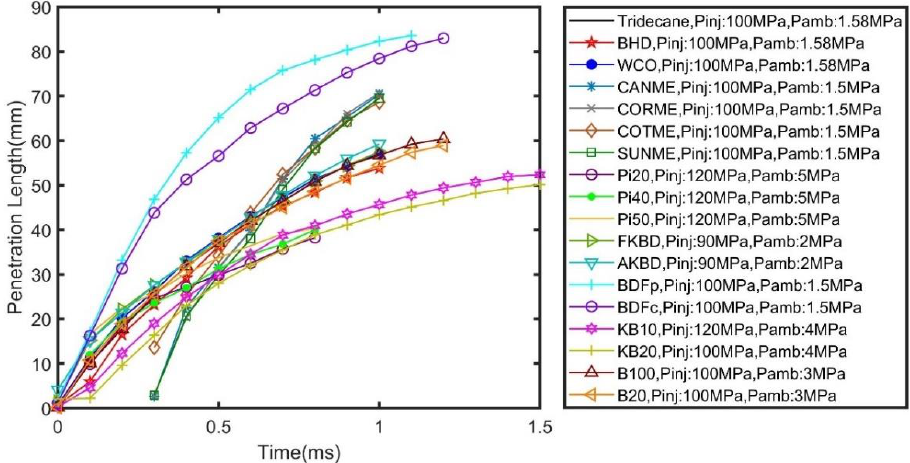
Figure 11. PL for biodiesel blends at various injection & ambient pressure [47,87,92,94,98,99].